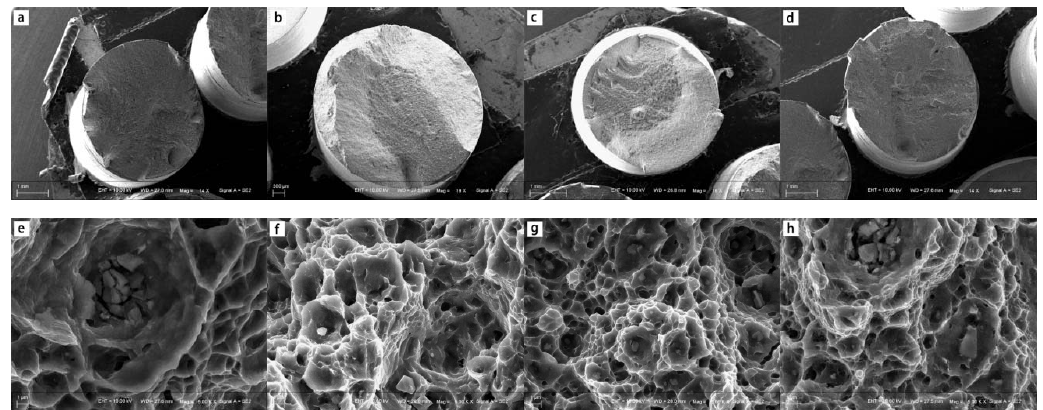
Figure 3. Mechanical properties of as ‐ extruded ZX30, ZK30, ZKJ300 and ZKXQ3000 alloys. ( a ) Tensile and ( b ) compression stress ‐ strain curves of four alloys.